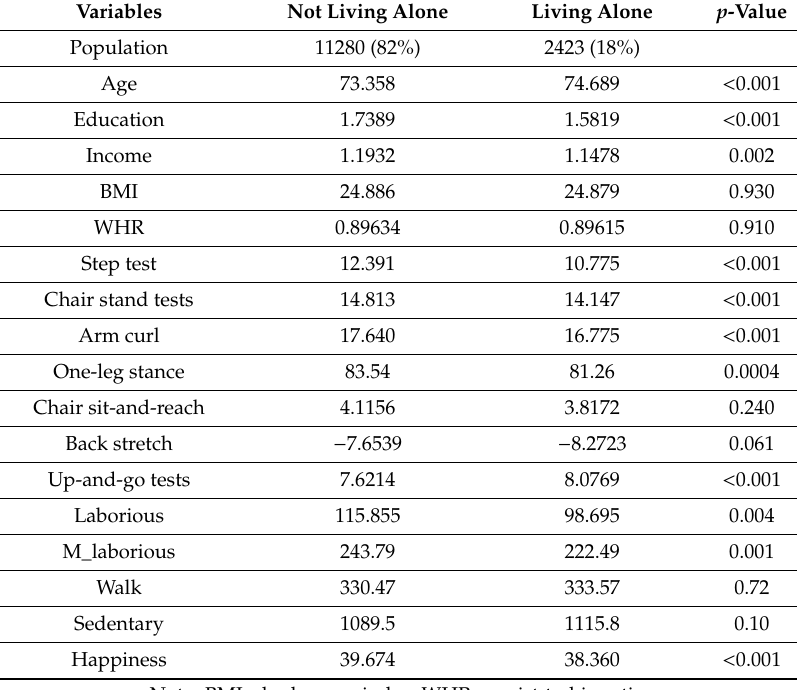
Table A1. t -tests analysis based on living alone.